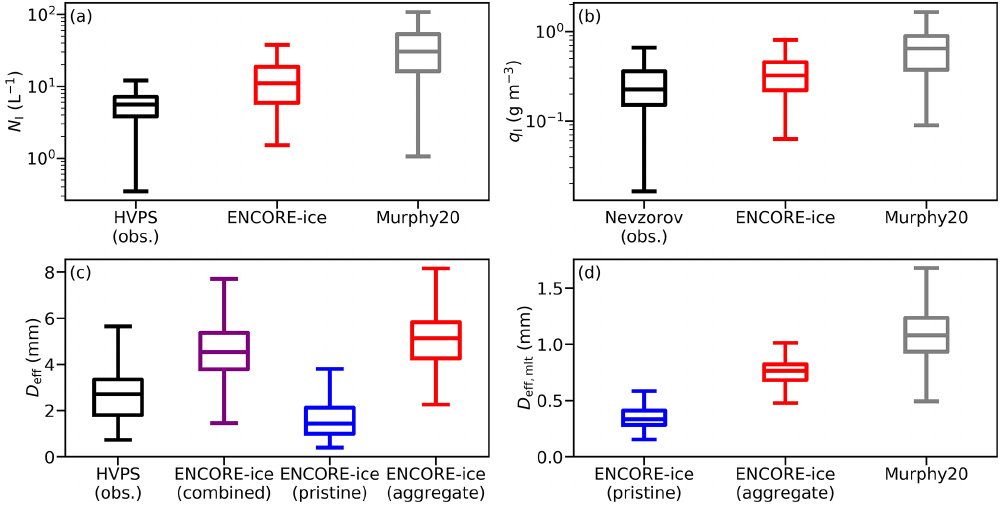
Figure 10. Box plots of in situ observations and retrievals from ENCORE-ice and Murphy20 for (a) total ice number concentration, (b) ice water content, (c) effective mean diameter using the maximum particle dimension as the size descriptor, and (d) effective mean diameter using the equivalent melted diameter as the size descriptor. The bottom and top of each box represent the 25% and 75% quartiles, and the line inside the box represents the median. The whiskers represent the range of data points within 1.5 times the interquartile distance. The included sample sizes for in situ data and radar gates are 347 and 1237, respectively.